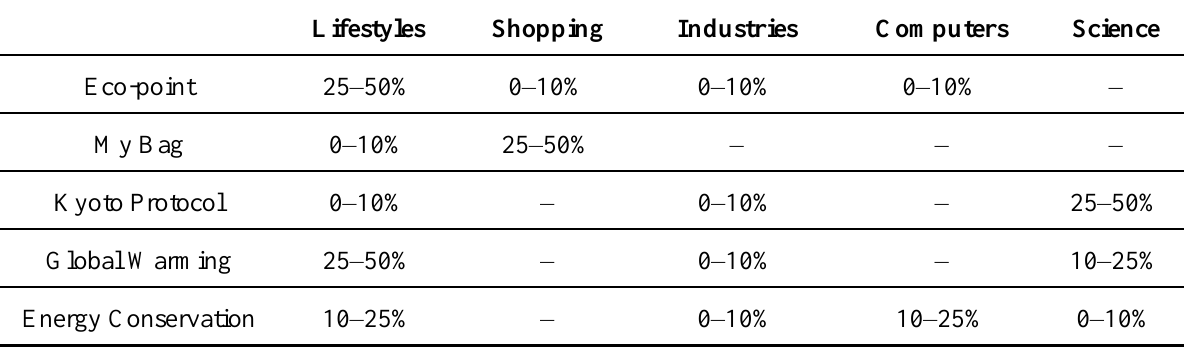
Table 2. Percentage of searches performed under five search